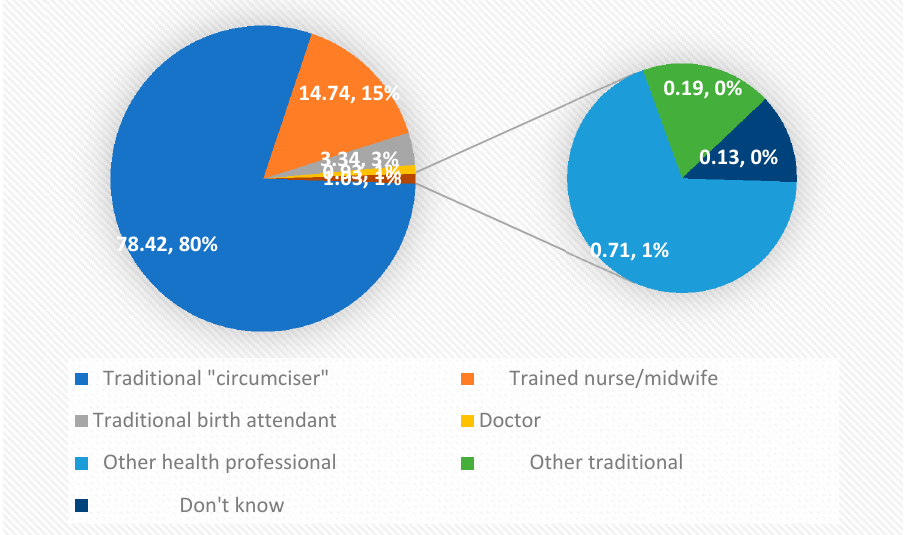
Figure 3. Type of health professional performing circumcision for daughters, Nigeria DHS.